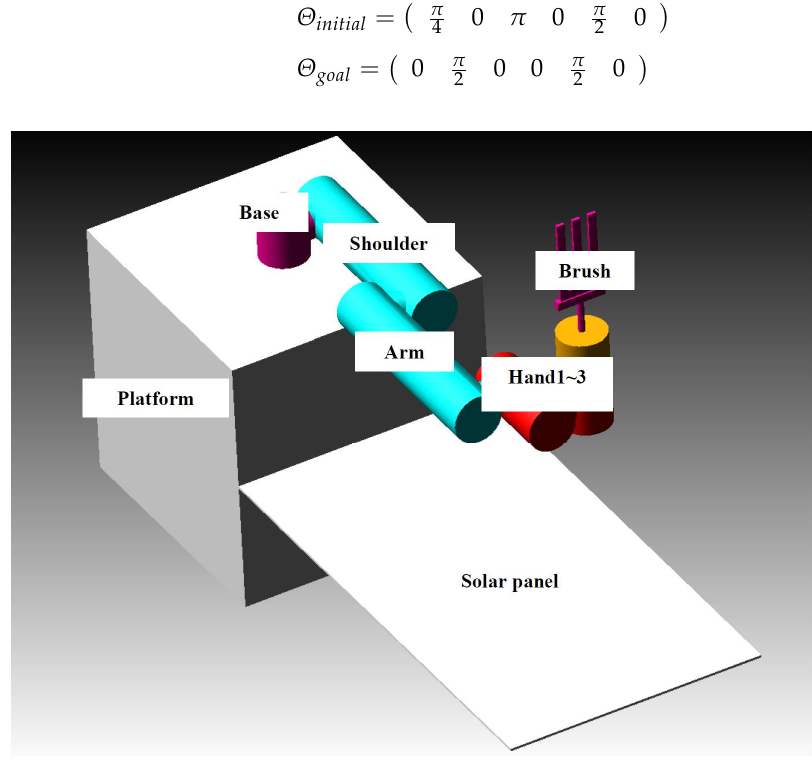
Figure 5. Configuration of the space detumbling robot.